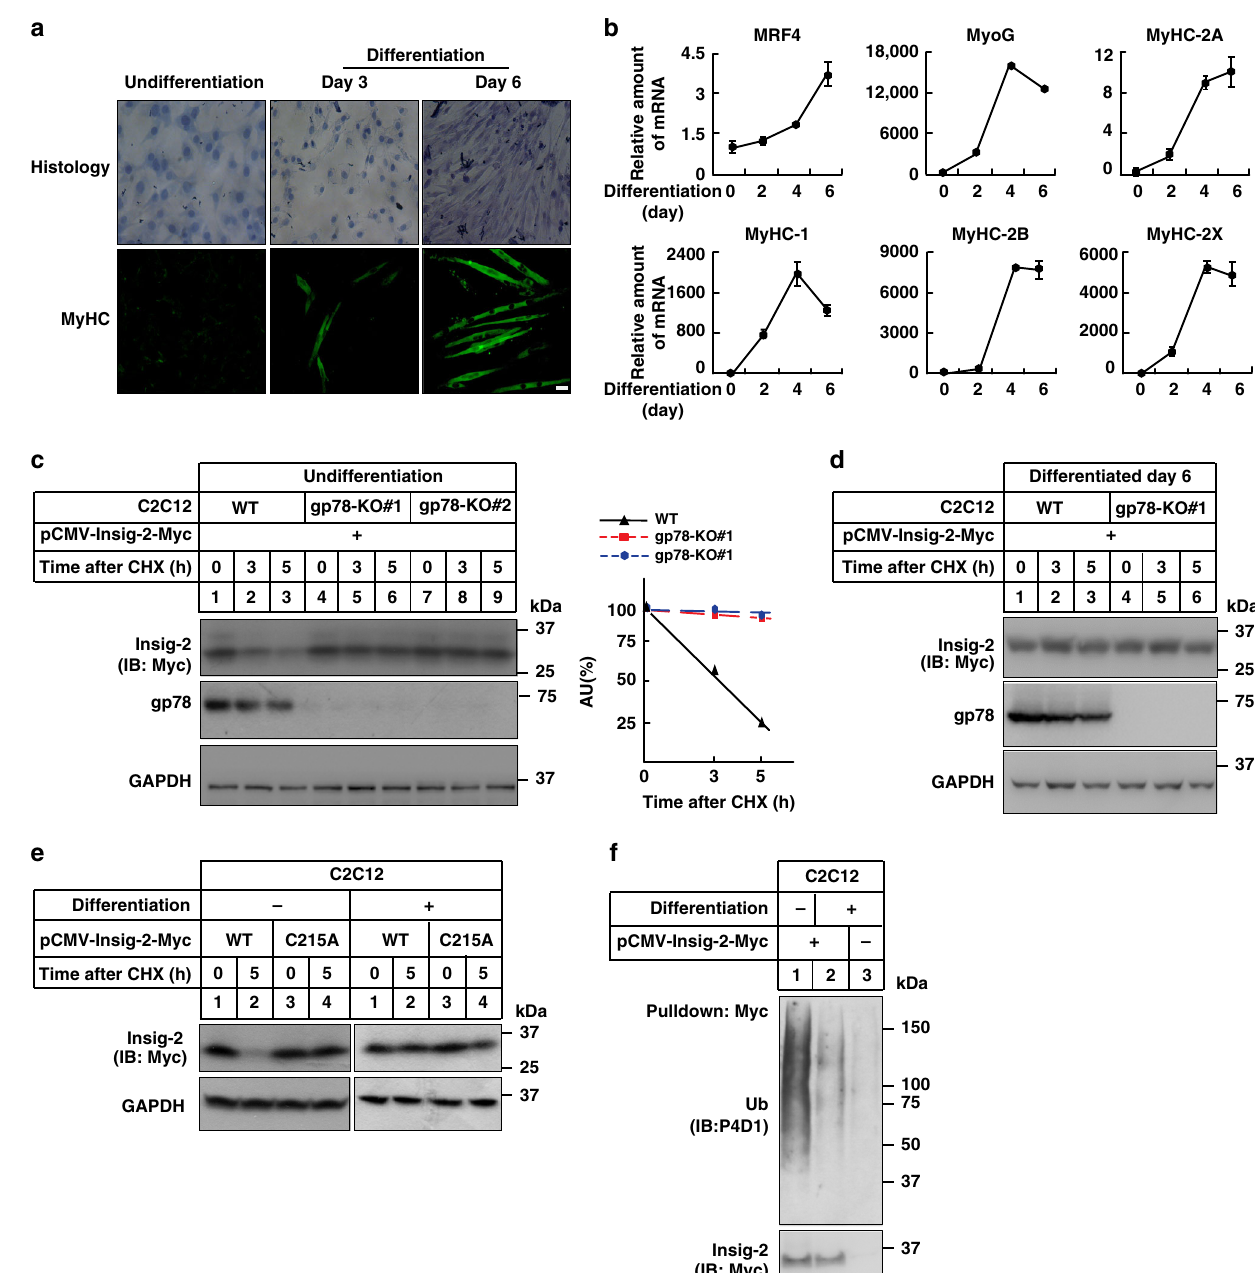
Fig. 3 Gp78 mediates Insig-2 degradation in the undifferentiated myoblasts but not differentiated myotubes. a Histologic and anti-MyHC immuno fl uorescent images of undifferentiated and differentiated C2C12 cells. Scale bar, 20 μ m. b Quanti fi cation of gene expression of several differentiation markers using RT-qPCR ( n = 3 biologically independent samples per condition, bars in black). Data are presented as mean ± s.d. c , d Undifferentiated WT or two lines of gp78 -knockout ( gp78 -KO#1 and #2) C2C12 cells ( c ) and WT or gp78 -KO#1 C2C12 cells at Differentiation Day 6 ( d ) were transfected with a plasmid expressing Insig-2 and treated with 100 μ M CHX for indicated time periods. Cells were harvested for immunoblotting analysis. Densitometric analysis of Insig-2 levels in ( c ). AU arbitrary unit. e Undifferentiated ( − ) and differentiated ( + , Day 6) C2C12 cells were transfected with plasmids expressing WT or C215A mutant forms of Insig-2. Forty-eight hours later, cells were treated without or with 100 μ M CHX for 5 h. Cells were harvested for immunoblotting analysis. f Undifferentiated ( − ) and differentiated ( + ) C2C12 cells were transfected with plasmids expressing Myc-tagged Insig-2 and HA-tagged ubiquitin. Forty-eight hours later, cells were treated with 10 μ M MG132 for 5 h and harvested for ubiquitylation